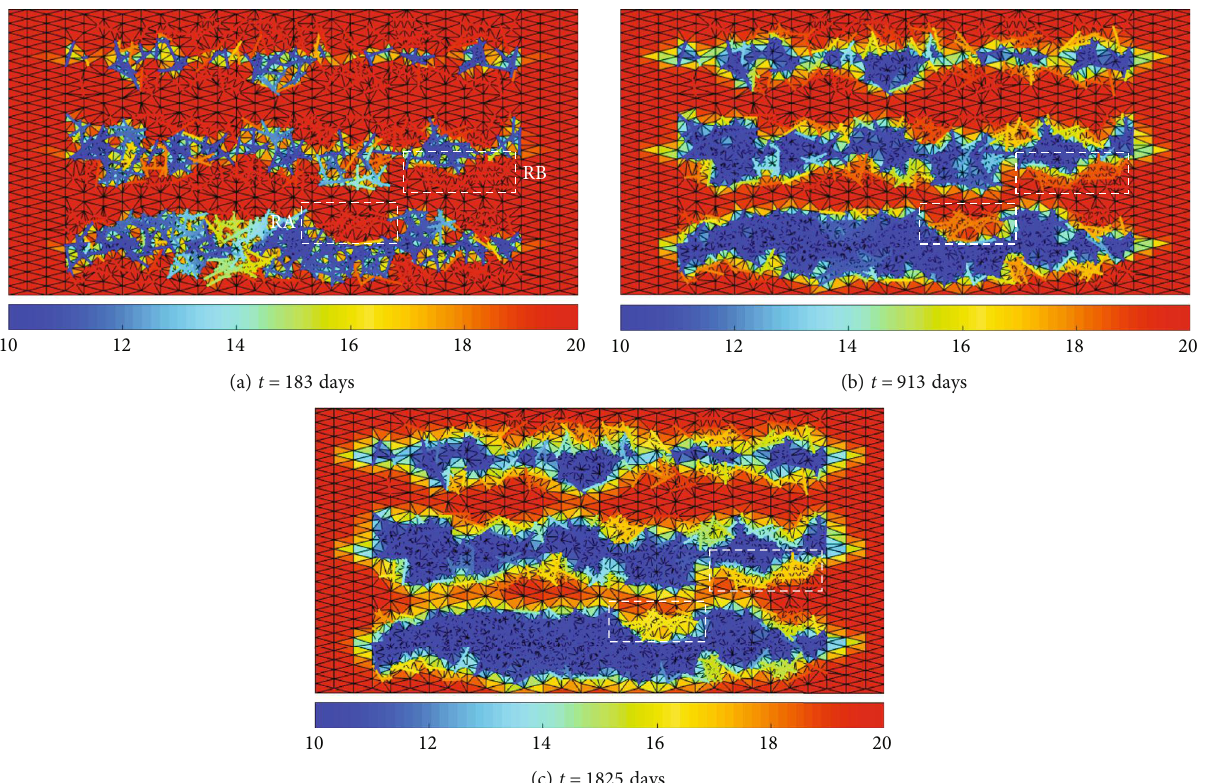
Figure 16: Time evolution of reservoir pressure pro fi le in the multi-well densely fractured